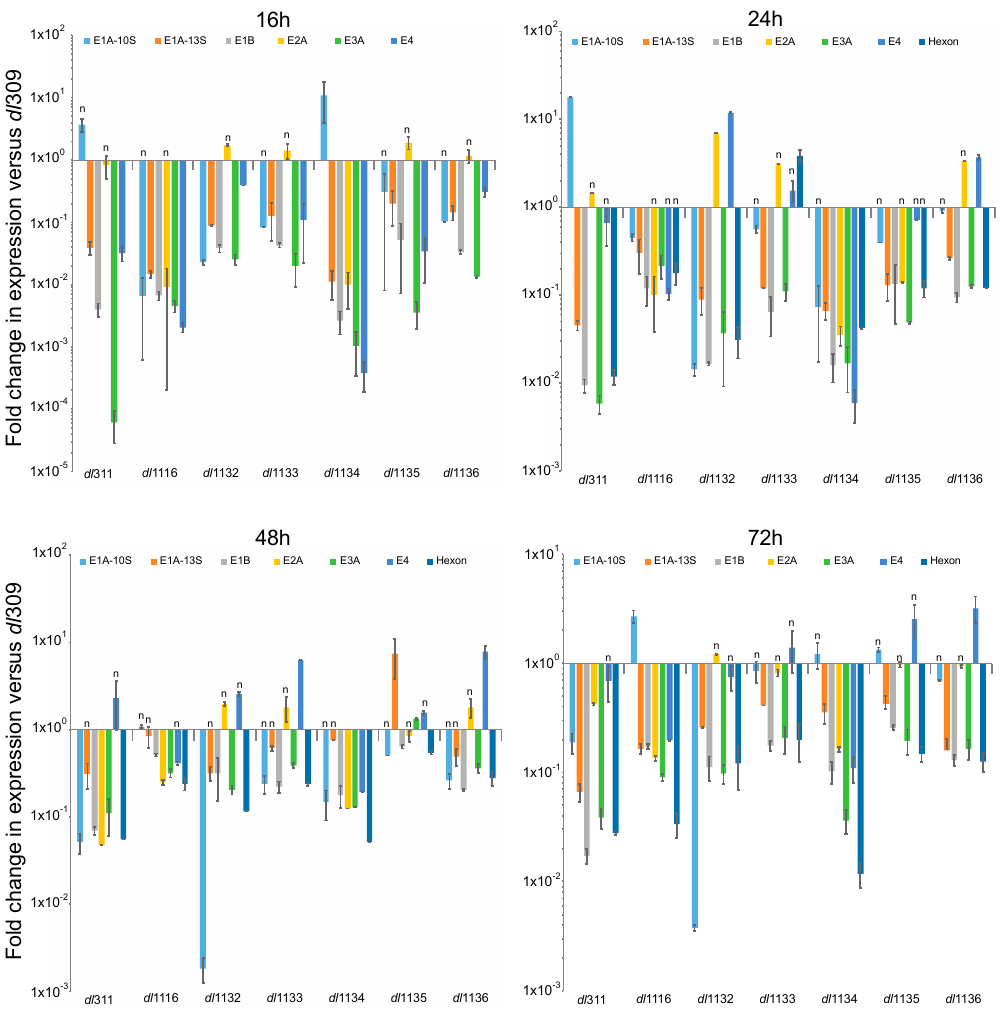
Figure 5. Relative viral gene expression profiles as compared to dl 309. Arrested WI-38 cells were infected at a MOI of 100 and total RNA was extracted at the indicated time points using the TRIzol reagent and treated with DNase I. RNA was converted to cDNA using VILO Master Mix reverse transcriptase and relative levels of viral mRNAs were quantified by qPCR using BioRad CFX96 with Applied Biosystems SYBR Master Mix for CFX. Expression levels were compared to those obtained from dl 309-infected cells using the Pfaffl method with GAPDH as a reference. Statistically insignificant differences are indicated with an n . The p values for all the genes at a time point that are significant are: 16 h— p < 0.023; 24 h— p < 0.0001; 48 h— p < 0.0063; 72 h— p < 0.0021. Error bars represent standard deviation of biological replicates, n = 3.